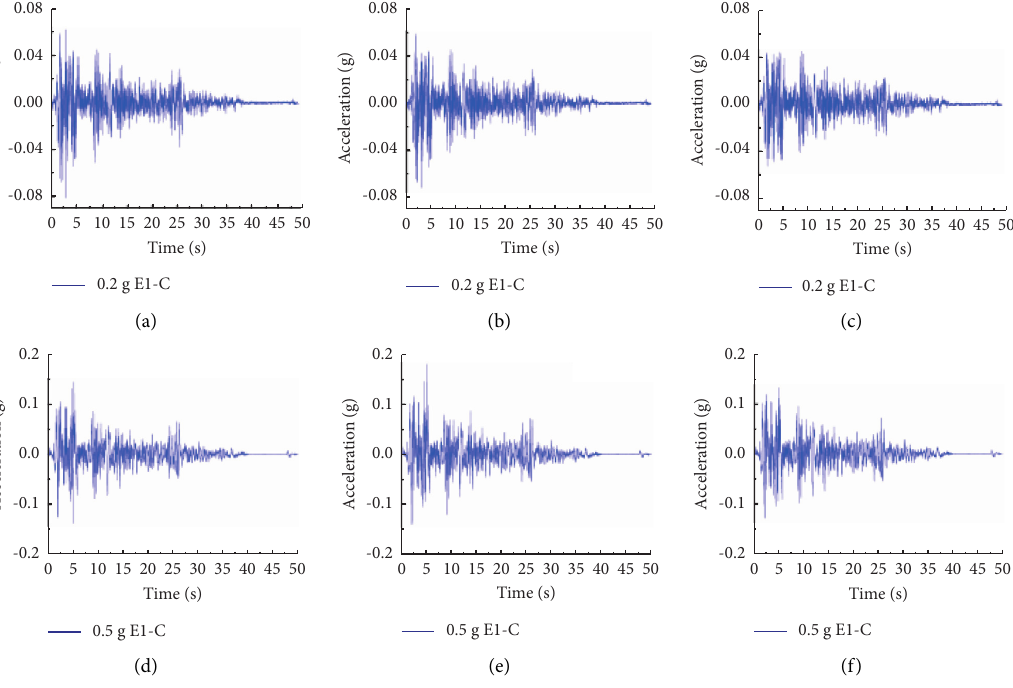
Figure 10: Acceleration time history of the monitoring point.